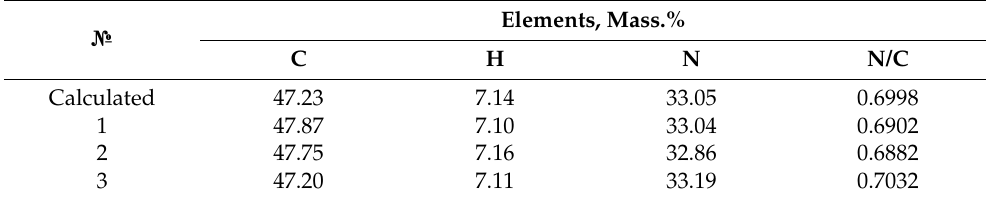
Table 2. THP elemental composition under varied synthesis conditions.